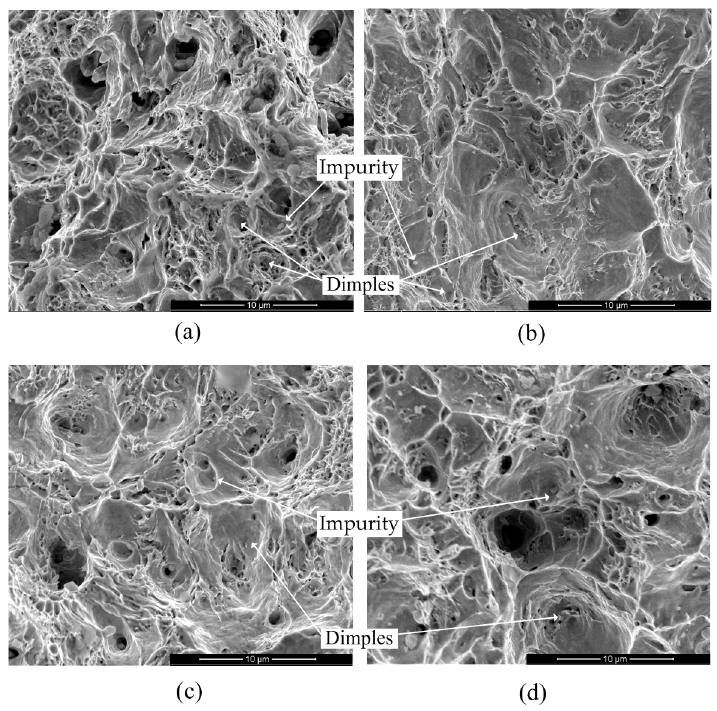
Figure 5. Fracture surface morphology of specimens of rebar grade HRB500 at different strain rates: ( a ) 500-0A ( ε = 0.0003 s − 1 ); ( b ) 500-1A ( ε = 5.6 s − 1 ); ( c ) 500-2A ( ε = 23.8 s − 1 ); and ( d ) 500-3A ( ε = 52.9 s − 1